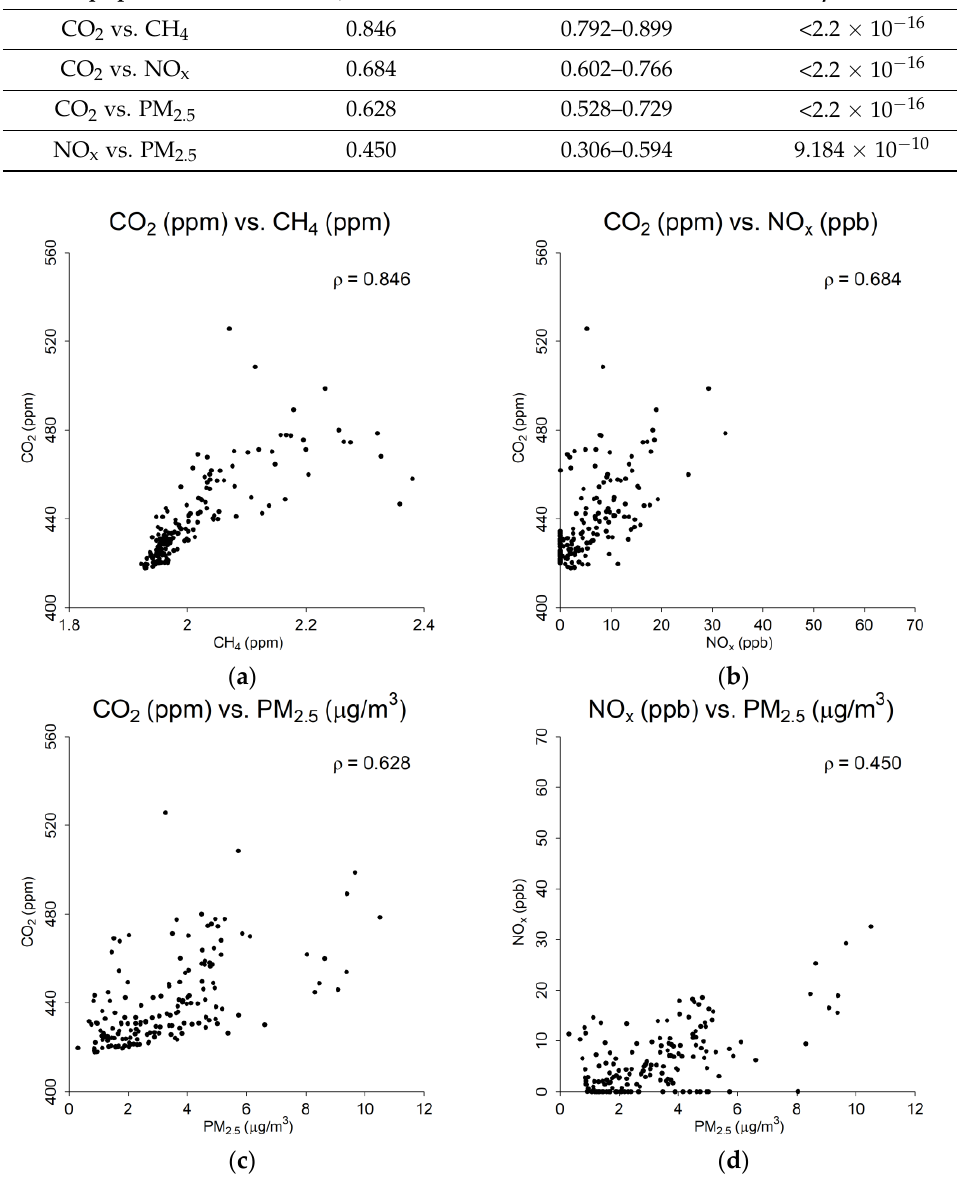
Figure 10. Van pollutant readings Bonneville Phase 2 campaign (13–27 February 2020) for ( a ) carbon dioxide vs. methane, ( b ) carbon dioxide vs. nitrogen oxides, ( c ) carbon dioxide vs. fine particulate matter, and ( d ) nitrogen oxides vs. fine particulate matter.